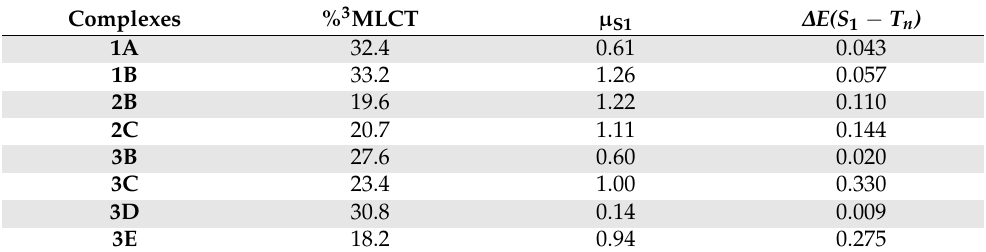
Table 4. Metal–ligand charge transfer character ( 3 MLCT, %), transition electric dipole moment ( µ S 1 , D) and energy gaps between the S 1 and T n states ( ∆ E(S 1 − T n ), eV) of studied complexes.